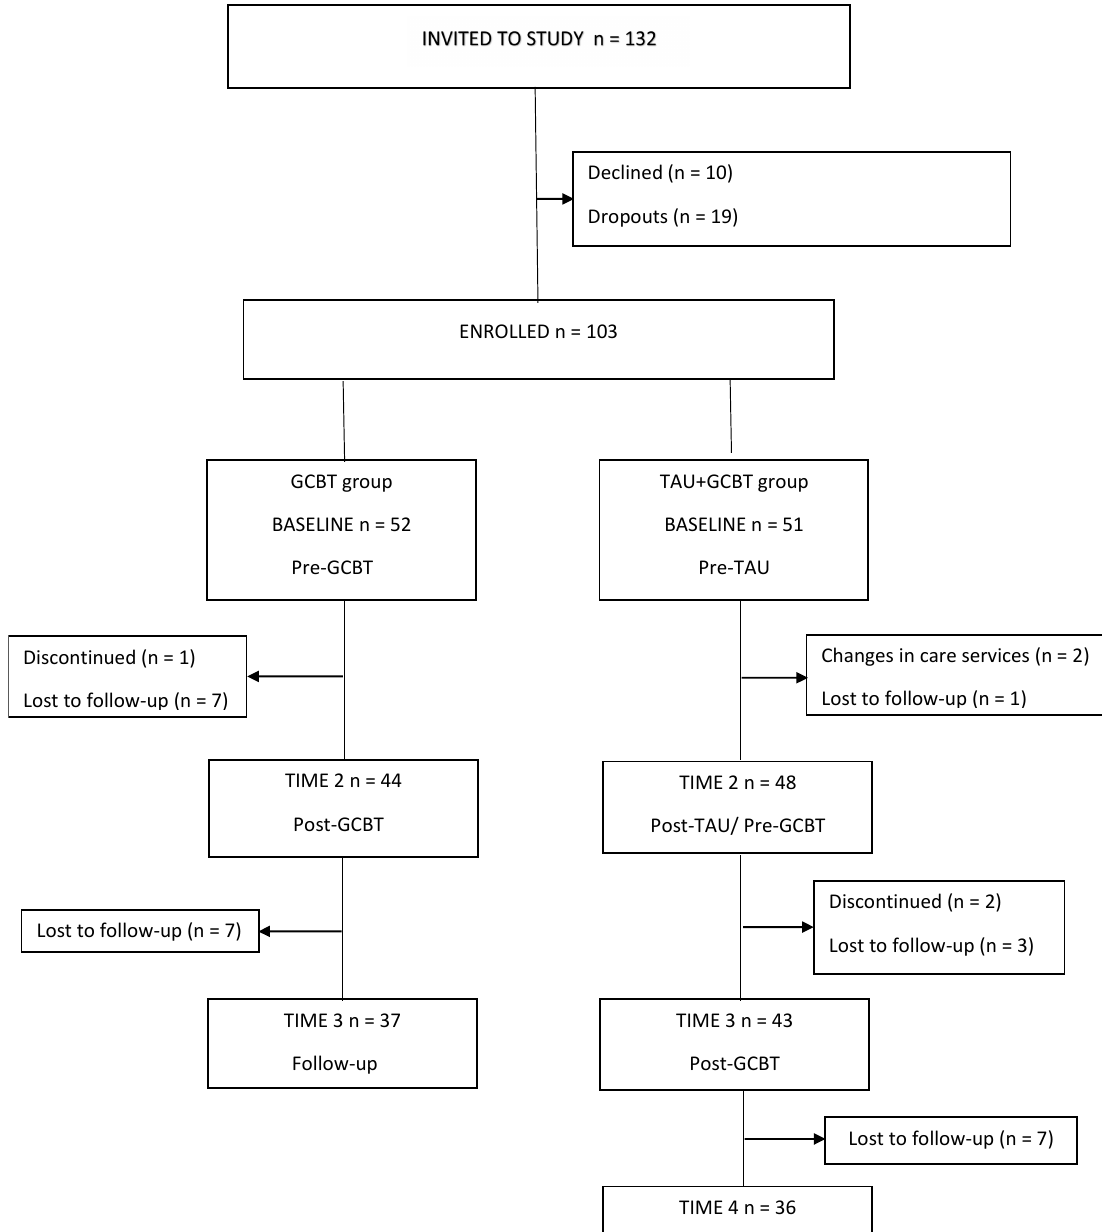
Figure 1. Study flowchart. Legend: From 132 subjects invited to the study 103 were enrolled. At each time point, parent- and teacher-rated questionnaires were completed in both study groups.